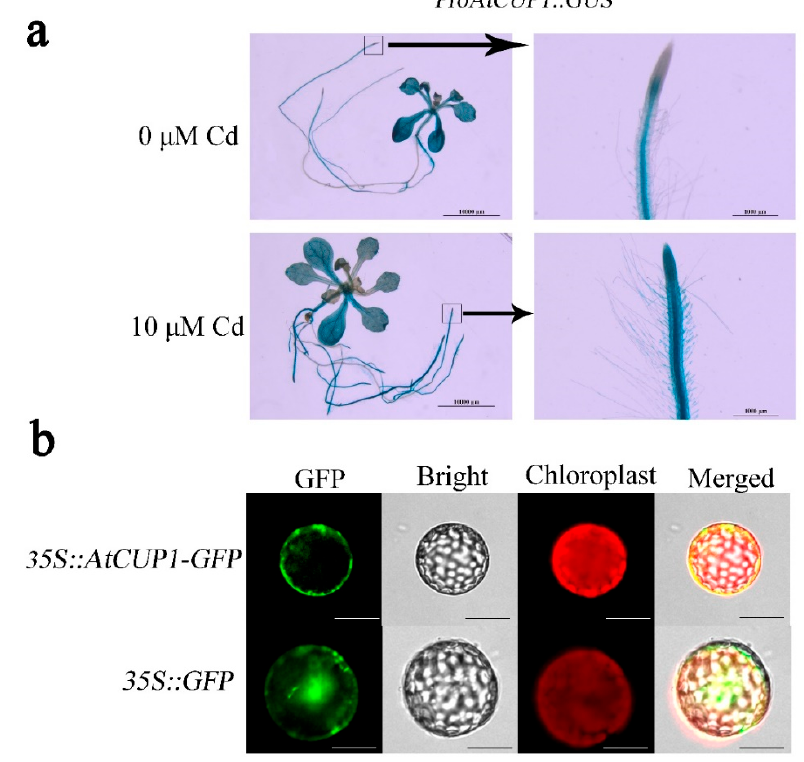
Figure 2. Expression pattern analysis of AtCUP1 in A. thaliana . ( a ) Tissue-dependent expression of AtCUP1 in A. thaliana detected by GUS histochemical assay of the transgenic plant with the GUS reporter driven by the AtCUP1 promoter. The right panels are zooms of the boxed area in the left panel. Bars indicate 10 mm in the left panels and 1 mm in the right. ( b ) Subcellular location of AtCUP1 in N . benthamiana protoplasts by fusion GFP. Bars indicates 20 µ